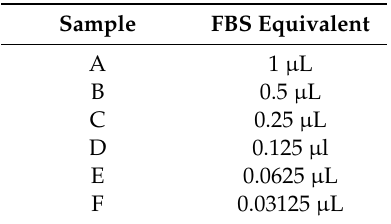
Serial dilutions of heat-inactivated fetal bovine serum (Gibco Life Technologies, Paisley, UK; #